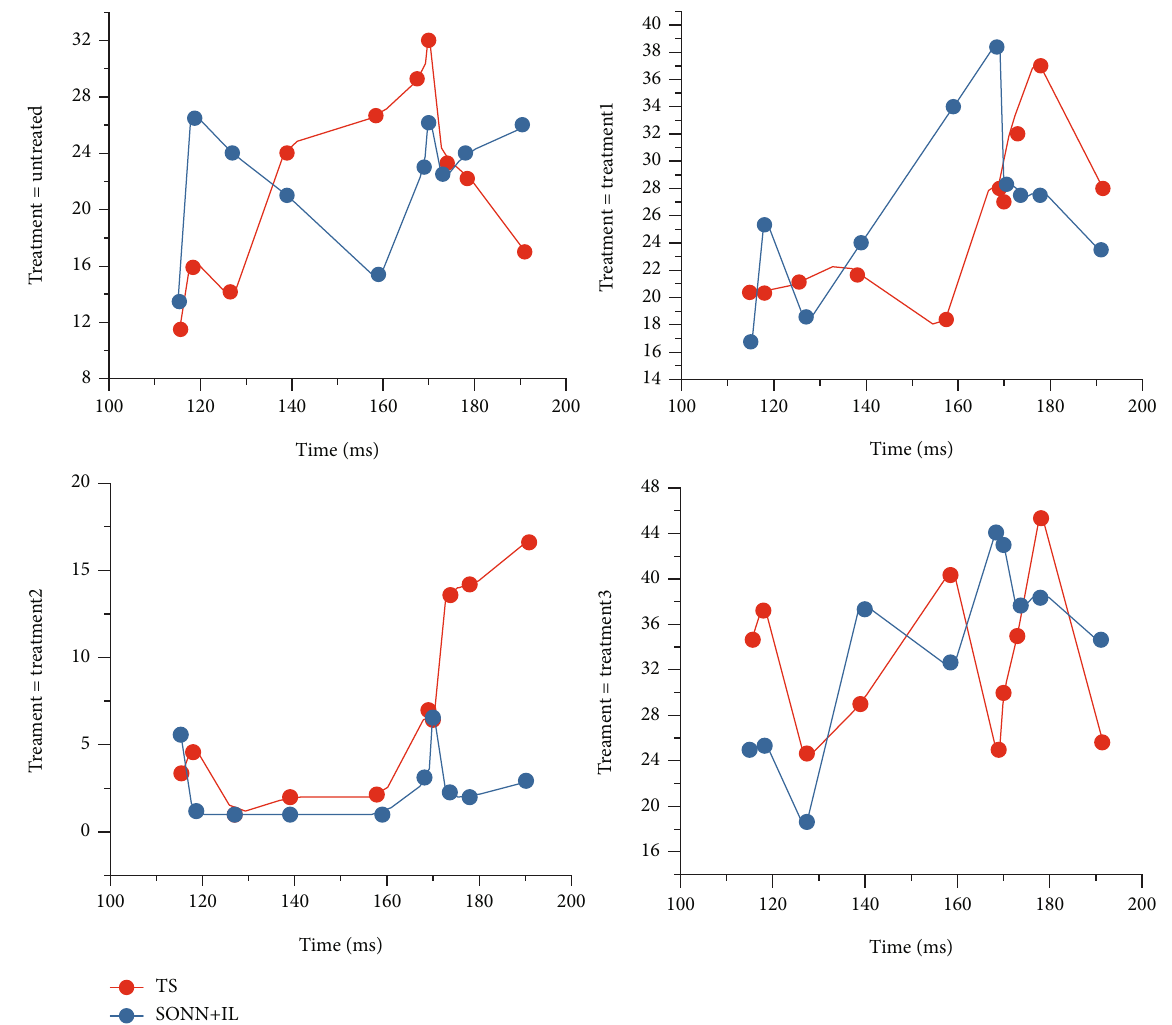
Figure 8: Experimental